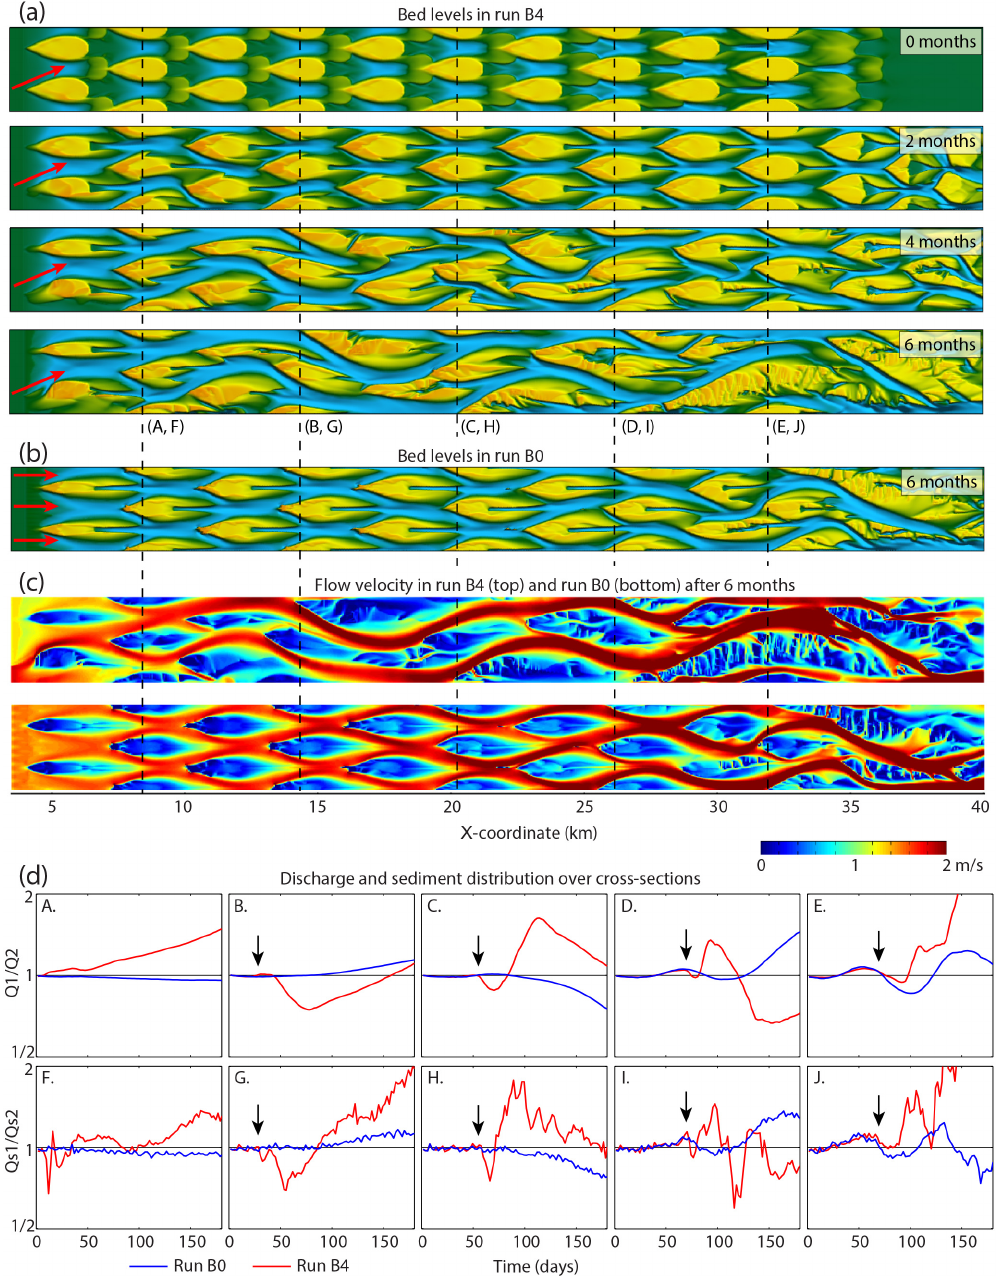
Figure 6. Evolution of the braided channel network and bar pattern in Run B4 with asymmetrical inflow: (a) time series of the bed level in Run B4, (b) bed level in Run B0 after 6 months for comparison with last time step of (a) , (c) depth-average flow velocity after 6 months in Run B4 and Run B0, and (d) discharge and sediment distribution over the branches with Q 1 and Qs 1 for the northern branches. The black arrows indicate the position of the propagating